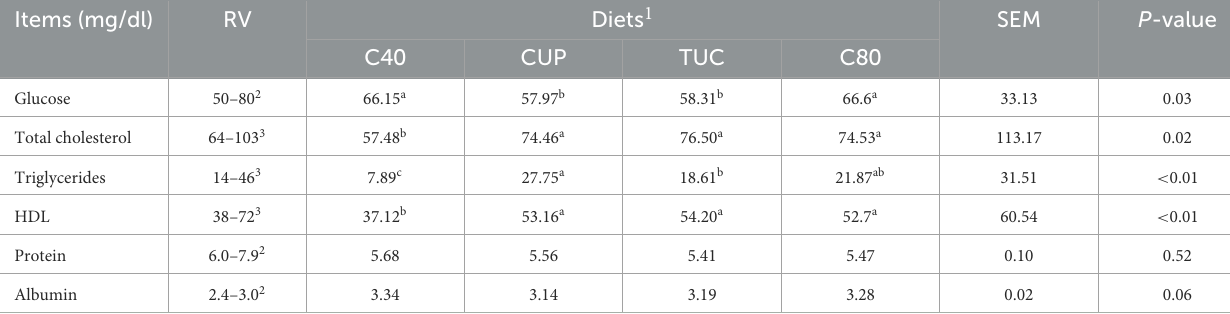
TABLE 5 Blood metabolites of confined sheep with diets containing Amazonian cakes (CUP and TUC). Items